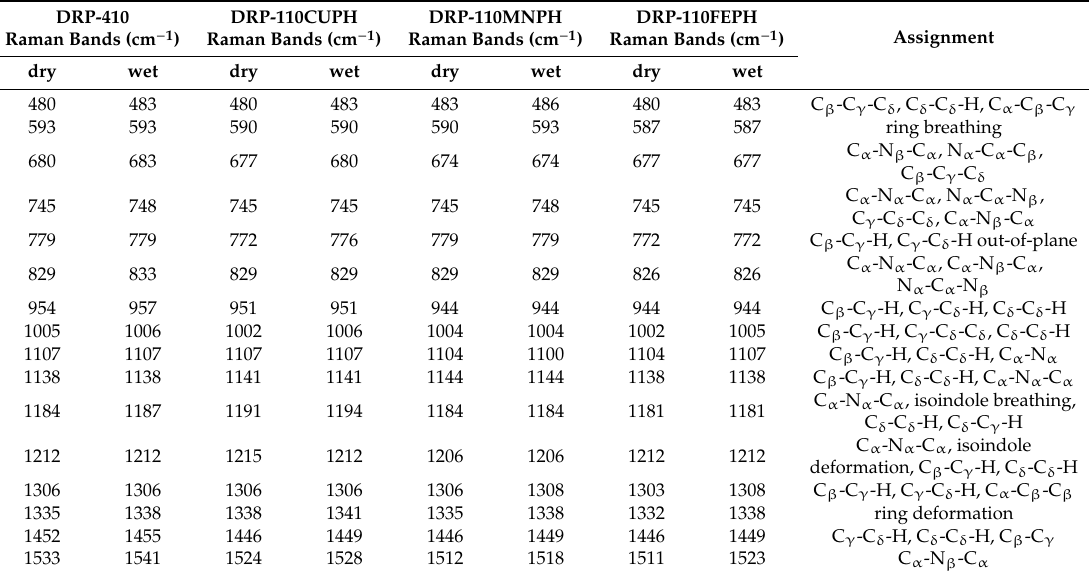
Table 1. Assignment of Raman bands of dry and wet CoPH (DRP-410), CuPH (DRP-110CUPH),